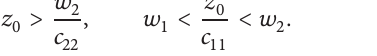
Figure 2: One coexistence state for the two species with 𝑤 ∗ ≤ 𝑢 ∗ .